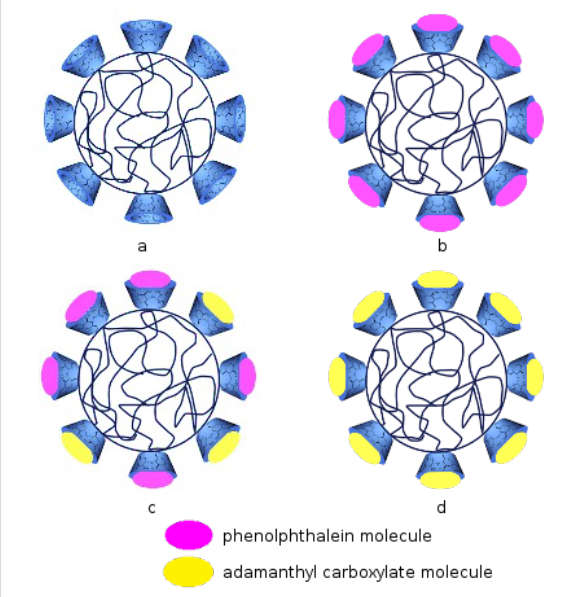
Figure 6: Schematic representation of the CD based nanoparticles morphology. (a) In water at pH > 7, (b) in phenolphthalein solution, (c) after small amounts of adamantyl carboxylate were added to the phenolphthalein solution, (d) after a large amount of adamantyl carboxylate was added to the phenolphthalein